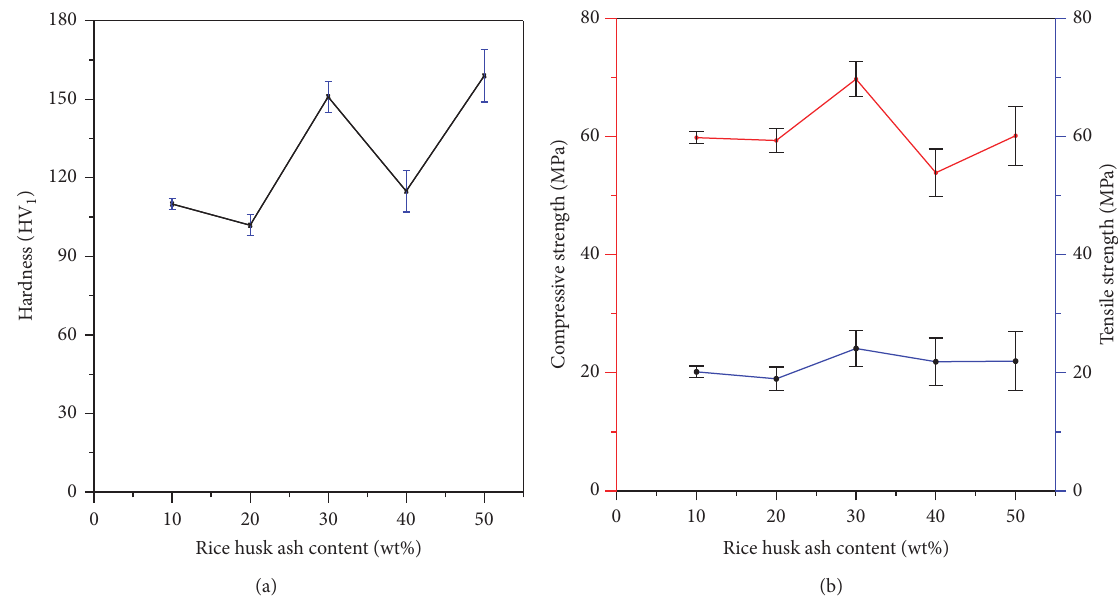
Figure 5: The variations in the mechanical properties of the content of rice husk ash of the samples of porous alumina ceramic sintered at 1600 ∘ C for 2hrs; (a) hardness and (b) compressive strength and tensile